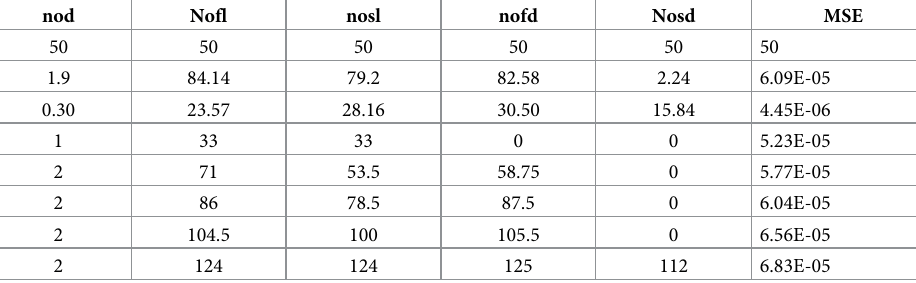
Table 5. Statistical description of 50 optimal parameter combinations.